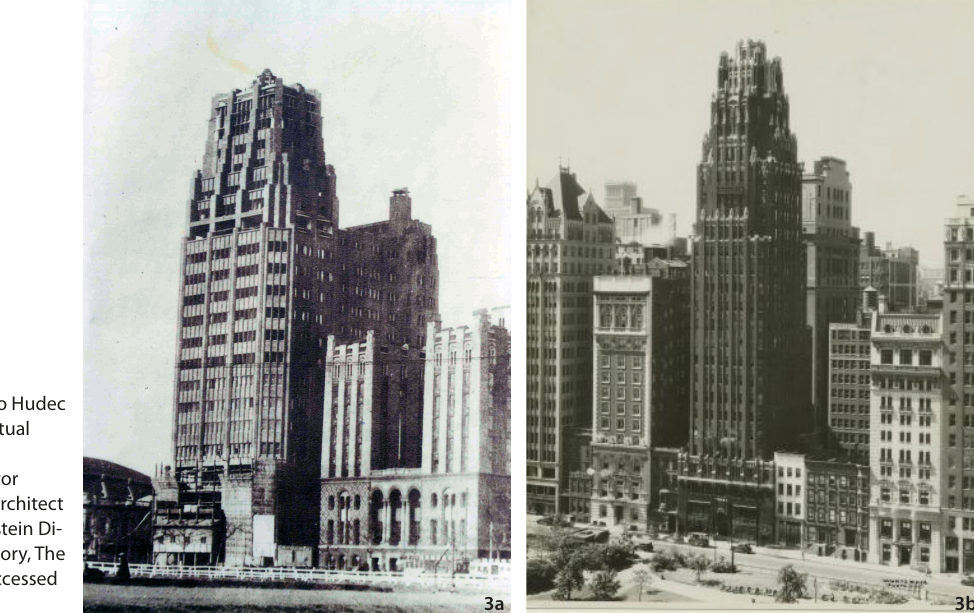
Figure 3a Park Hotel, Laszlo Hudec architect, 1934 (Source: Virtual Shanghai.net). Figure 3b American Radiator Building, Raymond Hood architect (Source: Irma and Paul Milstein Di- vision of United States History, The New York Public Library. Accessed June 27,